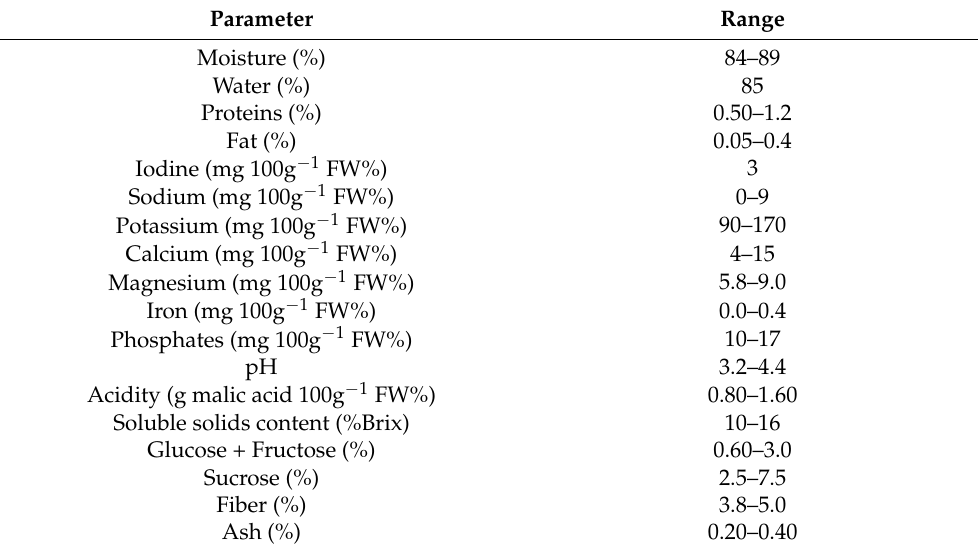
Table 1. Physicochemical and nutritional characteristics of fresh feijoa fruit.